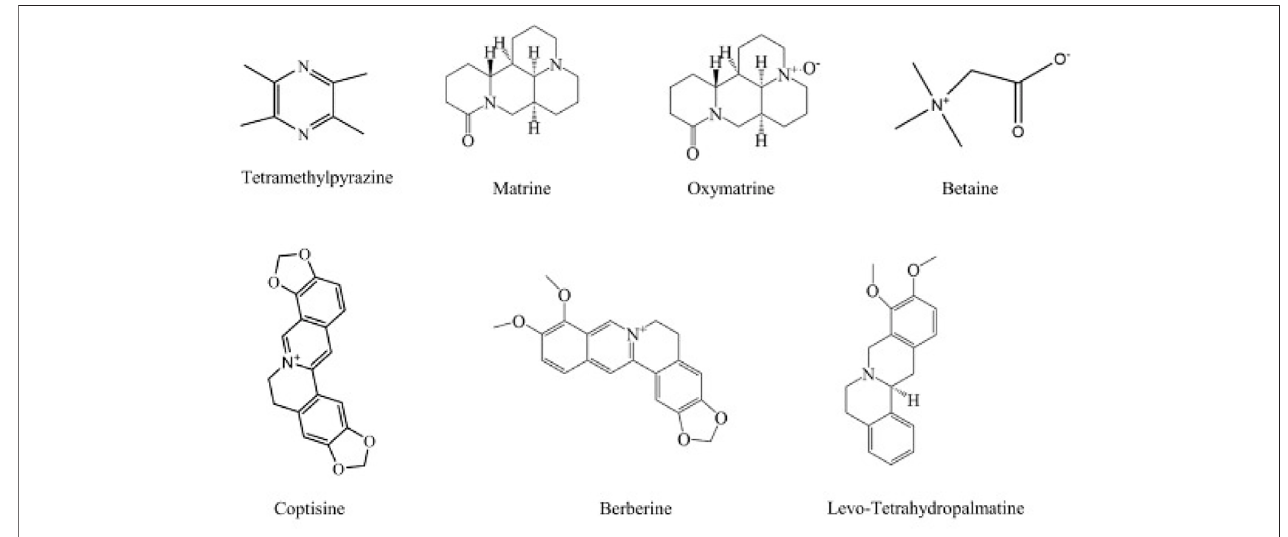
FIGURE 8 | The chemical structures of alkaloids showing anti-hepatopathy